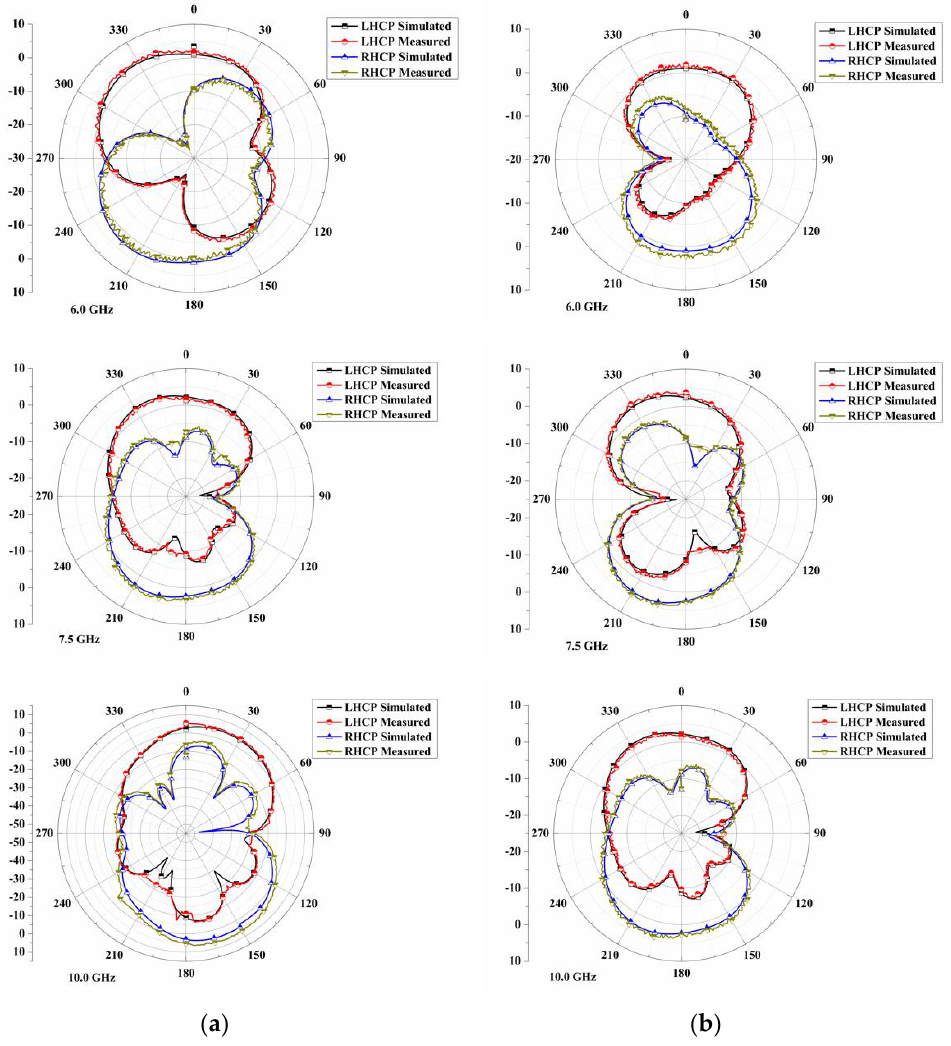
Figure 9. Radiation pattern comparison ( a ) x-z plane and ( b ) y-z plane. Additionally, the magnitude difference between LHCP and RHCP in the x-z plane between 0° and 180° is 0.03 dBi, 0.06 dBi, and 0.1 dBi, respectively, for 6.0 GHz, 7.5 GHz, and 10.0 GHz. The magnitude difference in the y-z plane at the above frequencies is 0.01 dBi, 0.07 dBi, and 0.11 dBi, respectively. In all frequencies, the RHCP component is somewhat larger than the LHCP component, and the magnitude difference is within acceptable limits. A pattern at lower and medium frequencies is almost in boresight, whereas a pattern at higher frequencies is slightly off in the broadside direction.